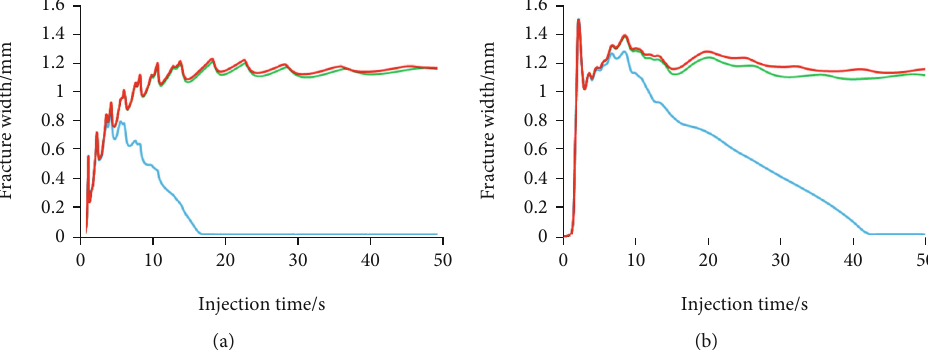
Figure 10: The maximum fracture width of each cluster as a function of time for di ff erent fracturing 484 fl uid viscosities: (a) case 1 (1 cp); (b) case 3